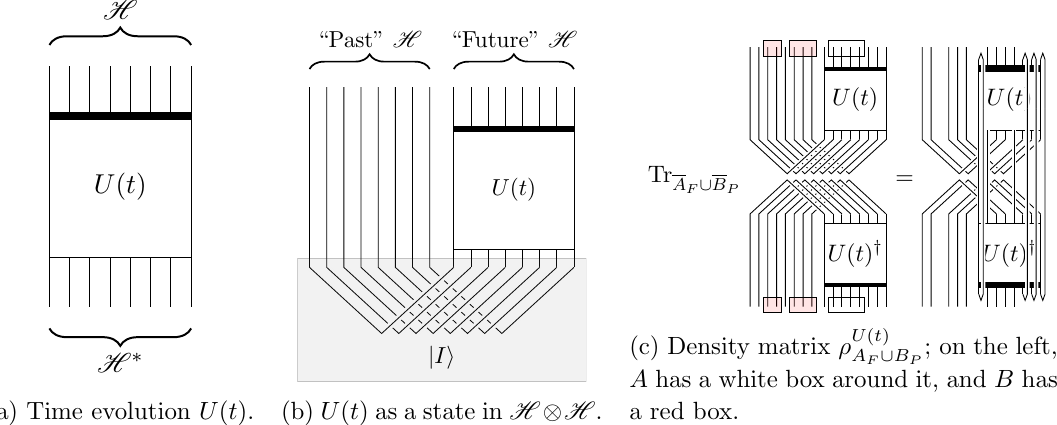
Figure 1. Pictorial representation and explicit construction of the mapping from time evolution operator U ( t ) to the state